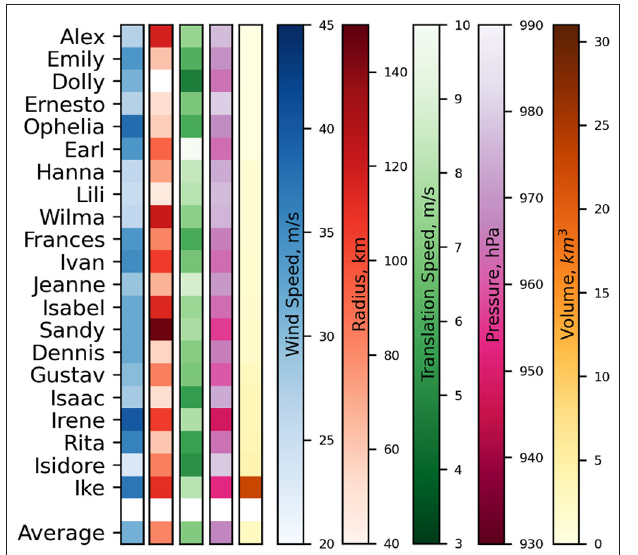
FIGURE 9 | Average hurricane characteristics of each simulated storm arranged from top to bottom by increasing inundation volume of the CTRL simulations. Magnitudes of hurricane characteristics that theoretically contribute positively to larger surges (e.g., higher wind speeds, larger radii, and slower translation speeds) are depicted by darker hues.